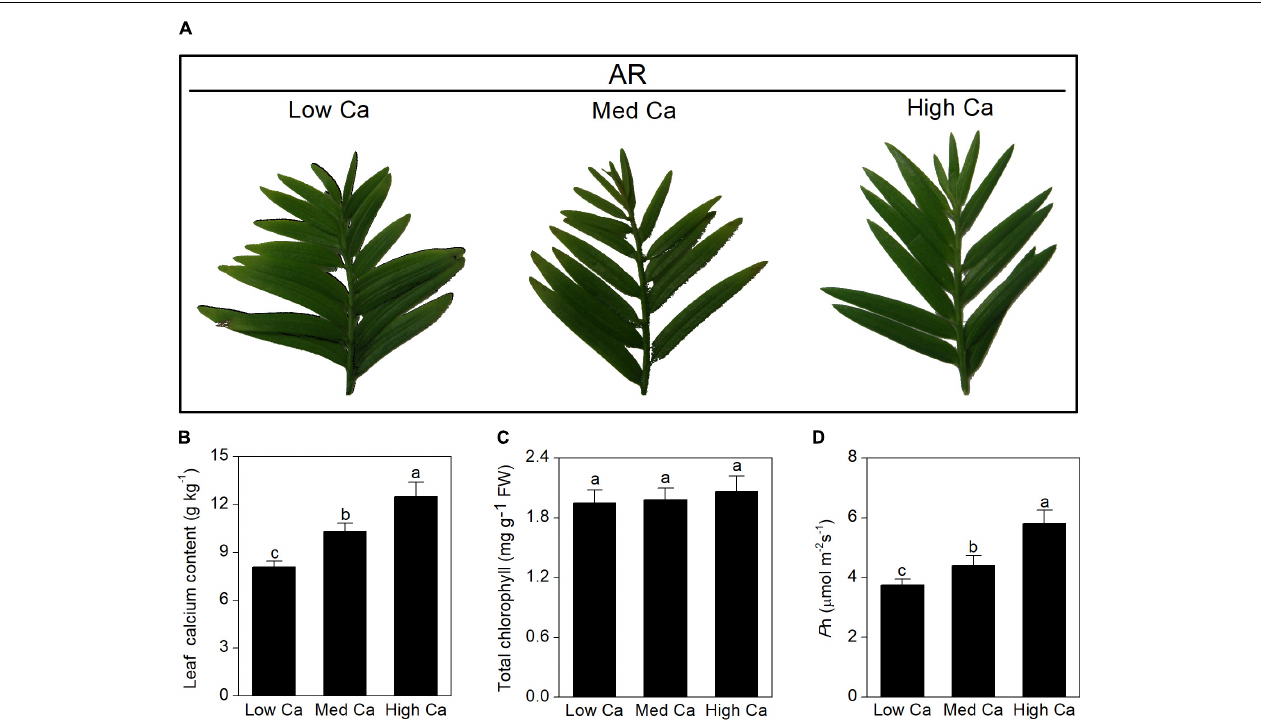
FIGURE 1 | Effects of different Ca treatments on morphological and physiological parameters of T. wallichiana var. mairei leaves under AR stress. (A) Phenotype on plant leaves. (B) Leaf Ca content. (C) Chlorophyll content. (D) Net photosynthetic rate ( P n). Different letters above columns indicate significant difference at p < 0.05.